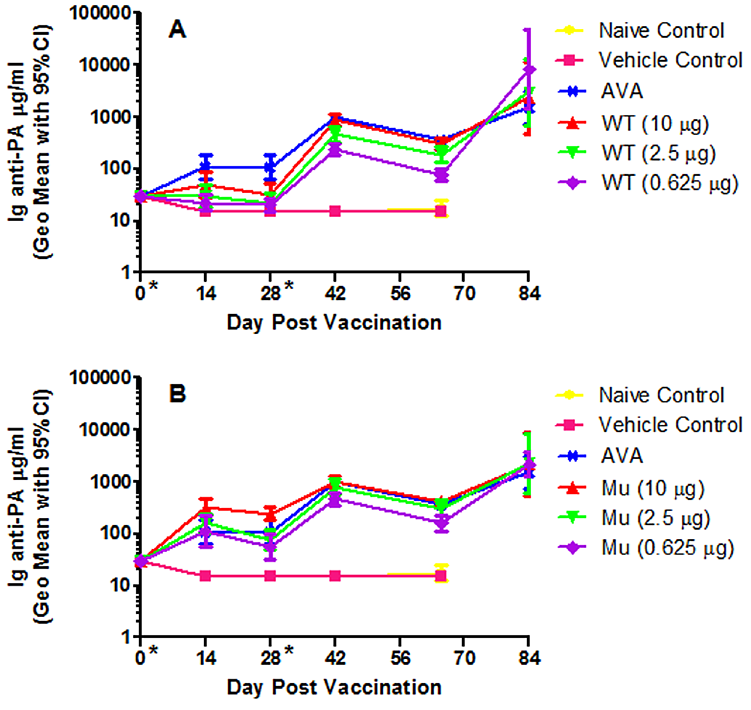
Fig 1. Ig anti-PA ELISA values ( μ g/mL). (A) generated from vaccinated wild type and (B) mutant rPA (geometric mean with error bars representing the 95% confidence